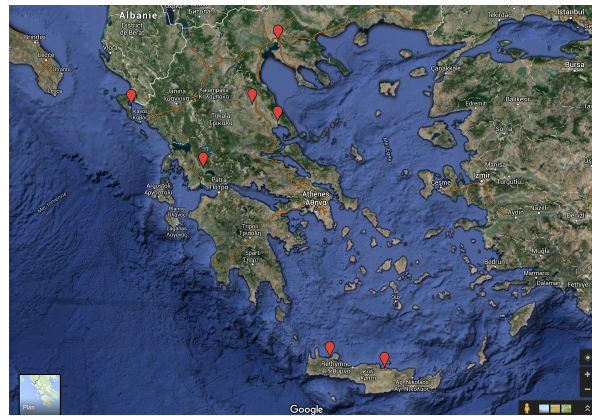
Figure 2: Studied urban agglomerations in Greece (from W to E: Corfu, Agrinio, Larissa, Volos, Thessaloniki, Chania, Heraklion - source: Google